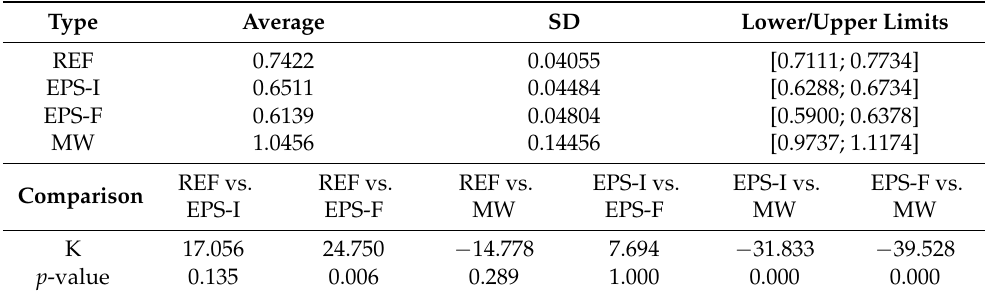
Table 5. Statistical analysis for the flexural strength test (MPa) in each group of mortar and its com- parison.